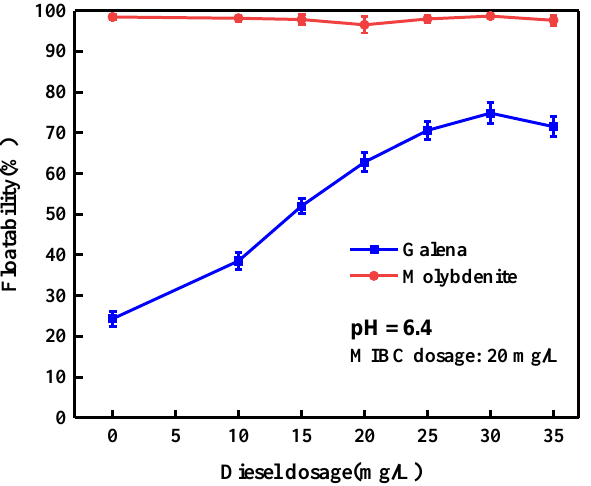
Figure 2. Floatability of galena and molybdenite as a function of diesel dosage.